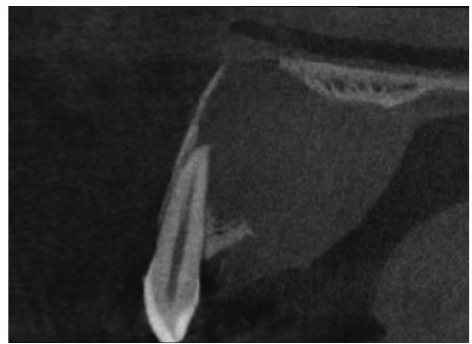
Figure 5: Pre-operative CBCT image in sagittal plane.